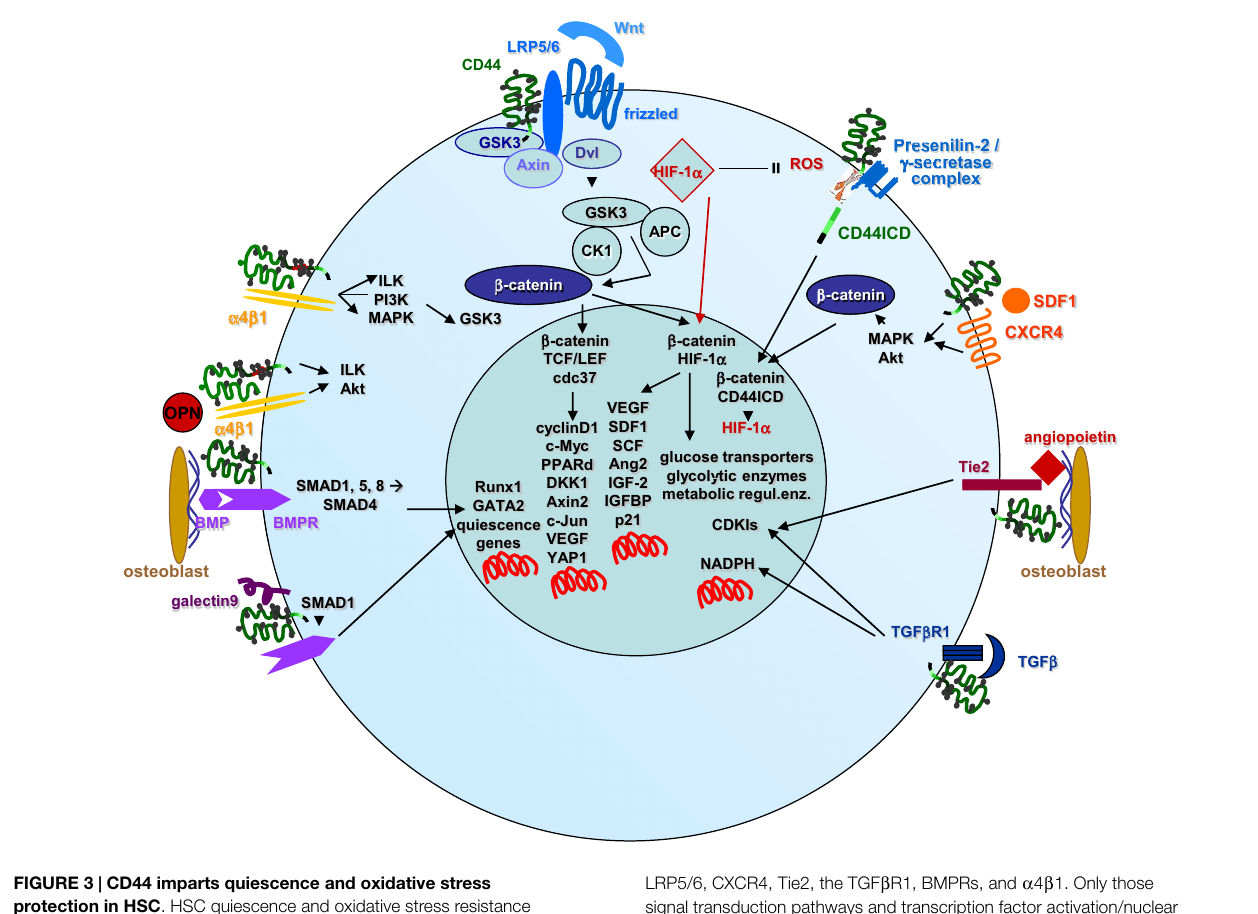
LRP5/6, CXCR4, Tie2, the TGF β R1, BMPRs, and α 4 β 1. Only those signal transduction pathways and transcription factor activation/nuclear localization are shown, where HSC CD44 plays a major role. Notably, CD44ICD is suggested to be an important cotranscription factor for HIF-1a, the major regulator to cope with the low oxygen in the osteogenic